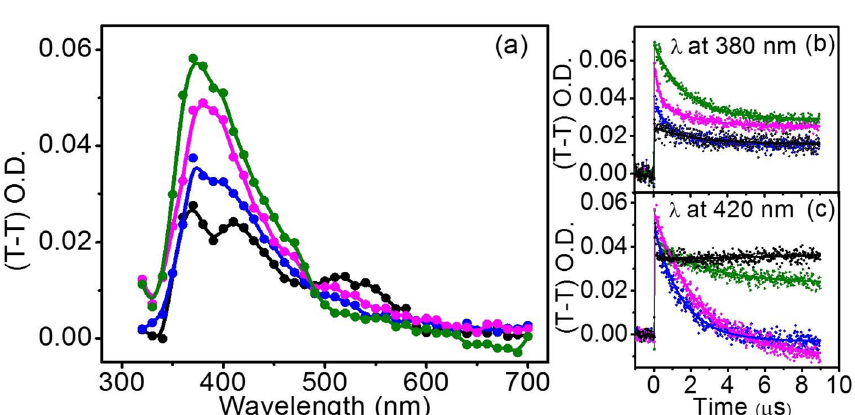
Figure 2. ( a ) Transient absorption spectra generated after 1 μs of laser flash (λ ex = 355 nm), for (blue circle) MQ, (pink circle) MQ-ADN (green circle) Au MQ-ADN, and (black circle) Fe MQ-ADN in 5% SDS. Their corresponding decay profiles are shown in ( b ) 380 nm and ( c ) 420 nm wavelengths. All the experiments are performed by keeping concentrations of MQ, ADN, AuNP, and FeNP at 0.1 mM, 2 mM, 2.8 μg/ml, and 2.8 μg/ ml, respectively. Similar spectra at 4 μs time delay is shown in